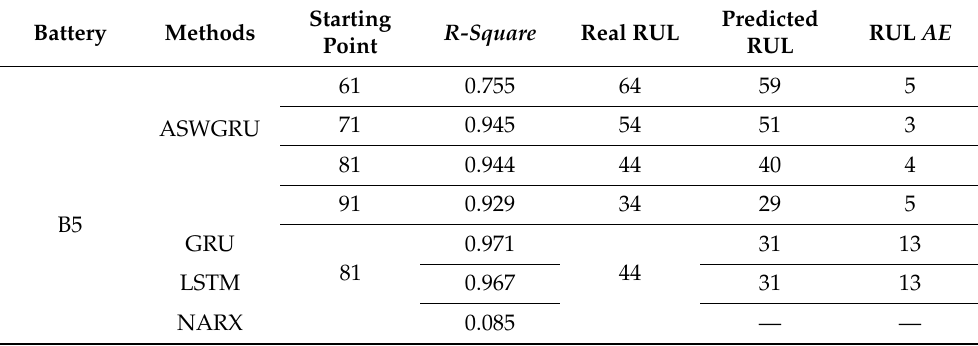
Table 3. The obtained results with different prediction start points for B5.